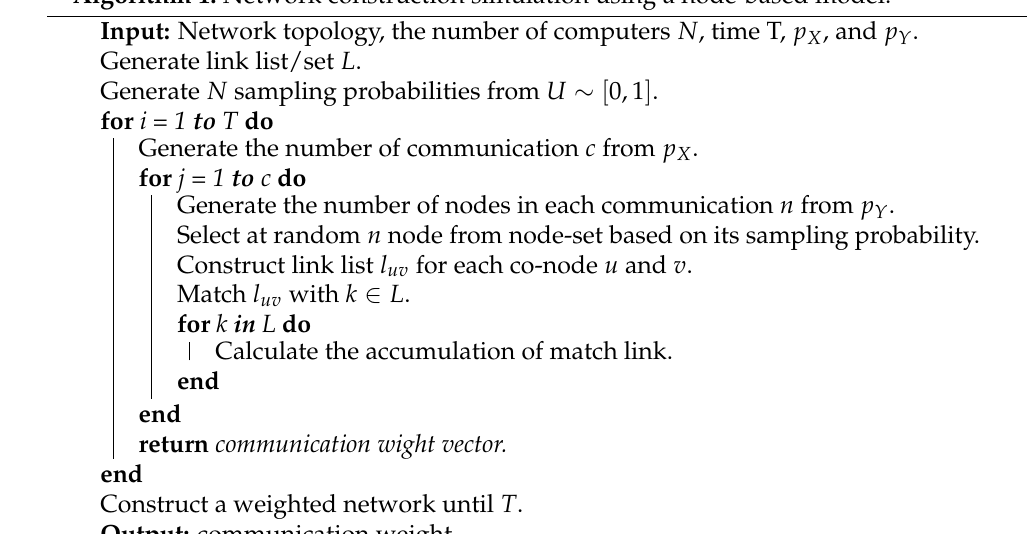
Figure 3. Effect of c and n on the number of communications in the network during a day. ( a ) Change in c for a given n . ( b ) Change in n for a given c . Algorithm 1: Network construction simulation using a node-based